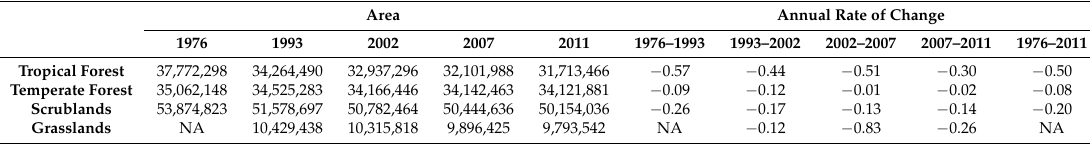
Table 1. Annual land use change in four ecosystems in Mexico (ha and